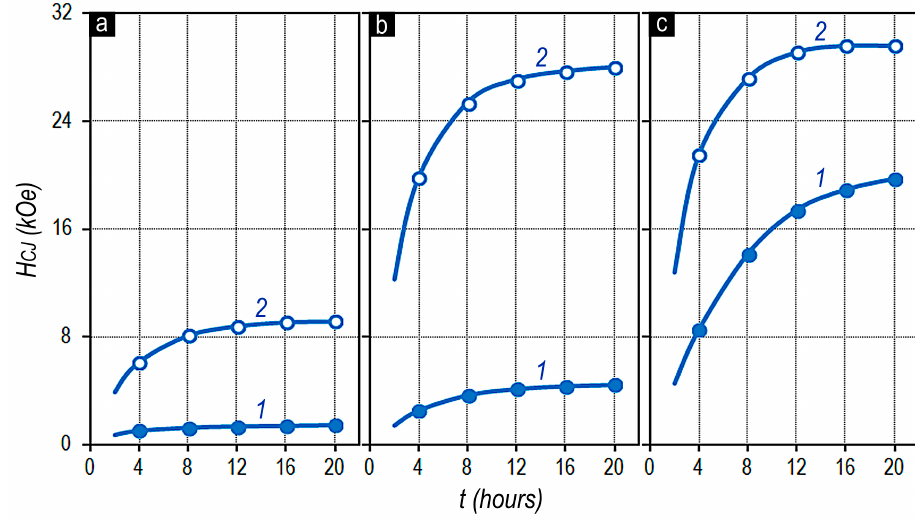
Figure 7. Effect of isothermal aging at 800 ° С on the coercive force of experimental Sm 0.85 Zr 0.15 (Co 0.702 Cu 0.088 Fe 0.210 ) Z alloy samples with z = 6.0 ( a ), 6.5 ( b ) and 6.8 ( c ) subjected to subsequent (1) quenching to room temperature and (2) stepped aging (or slow cooling) to 400 ° С .